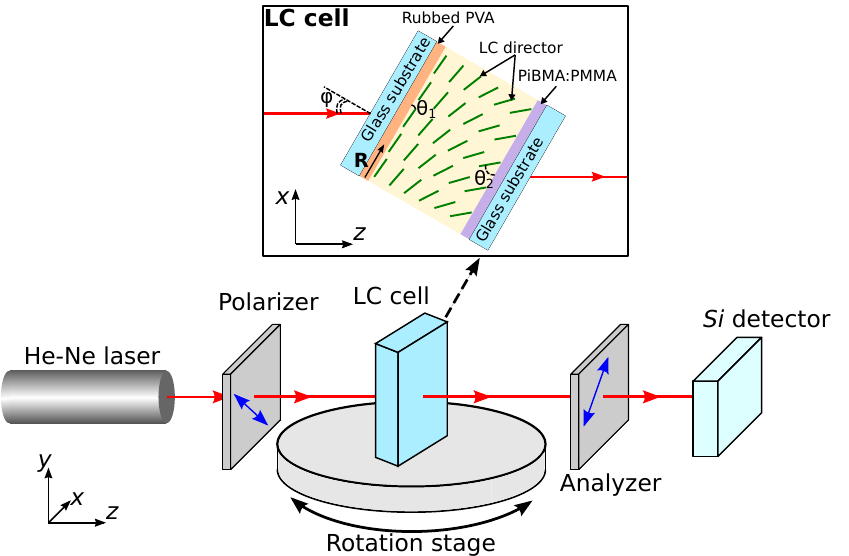
Figure 2. Scheme of optical setup to measure the director tilt angle on substrates by the oblique light incidence method. The inset is the scheme of LC